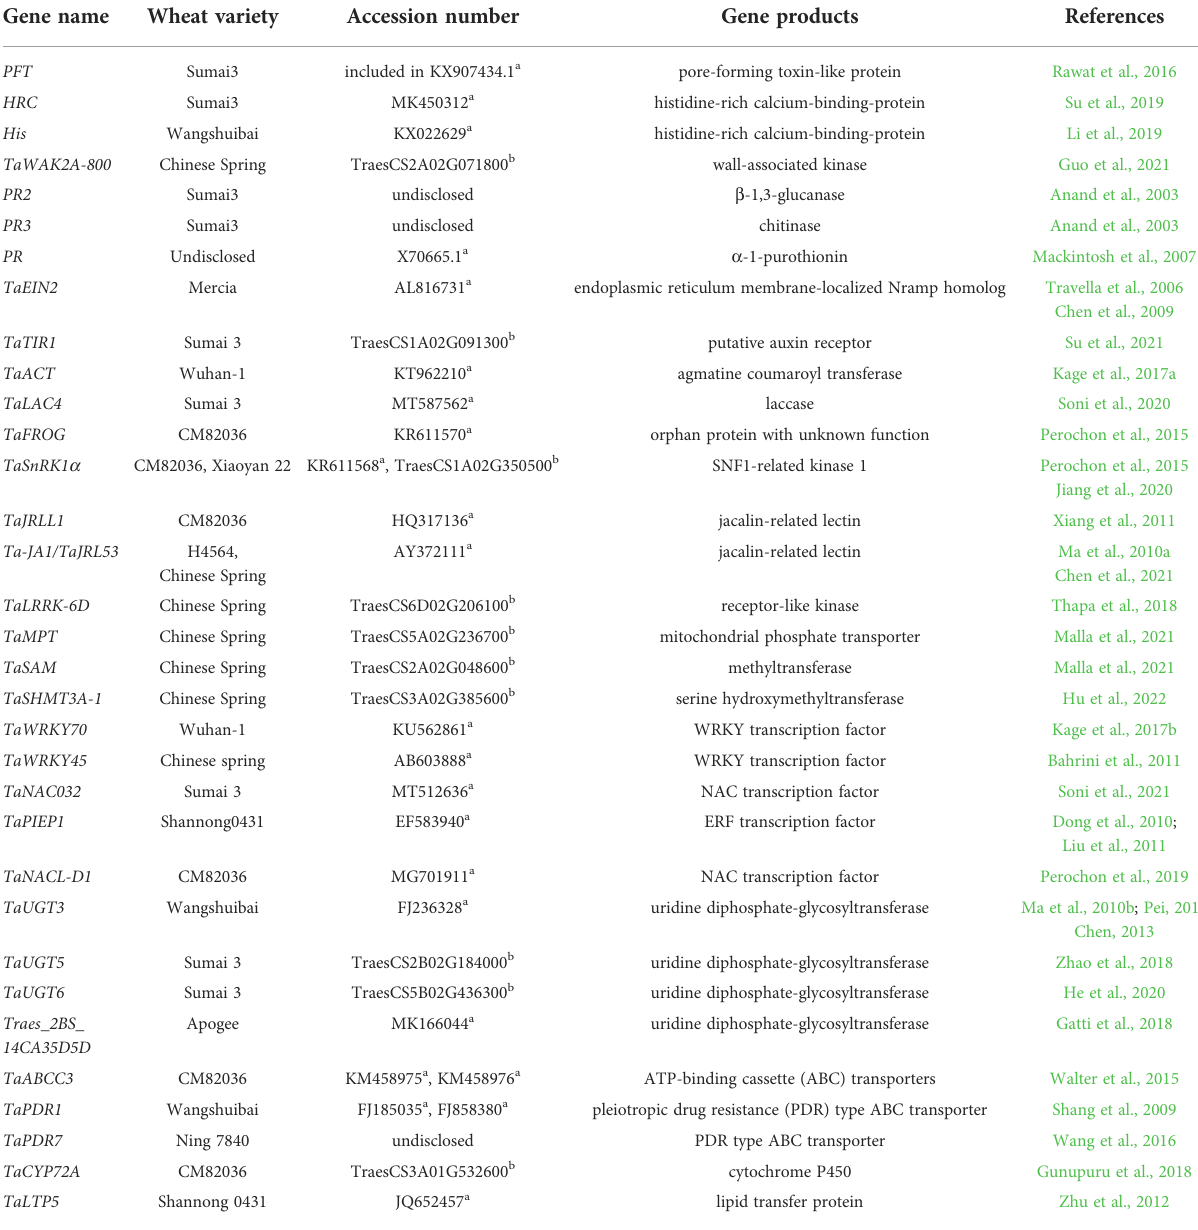
TABLE 1 Genes identi fi ed with FHB resistance in various common wheat